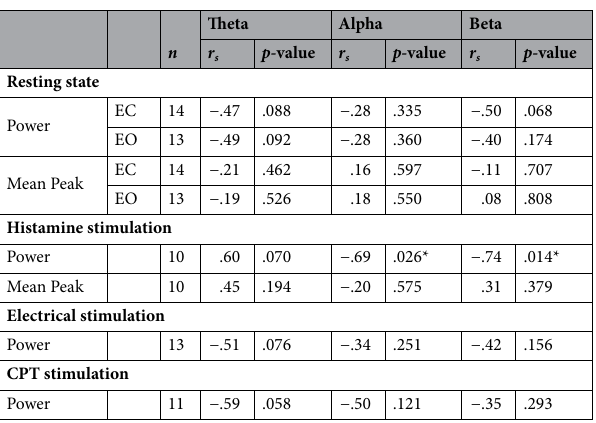
Table 5. Spearman’s correlation coefficient ( r s ) between power and mean peak frequencies during rest, with eyes closed (EC) or eyes open (EO), and stimulation states in theta, alpha, and beta frequency bands with patients’ total injured body surface area. * p < .05; ** p < .01; *** p <